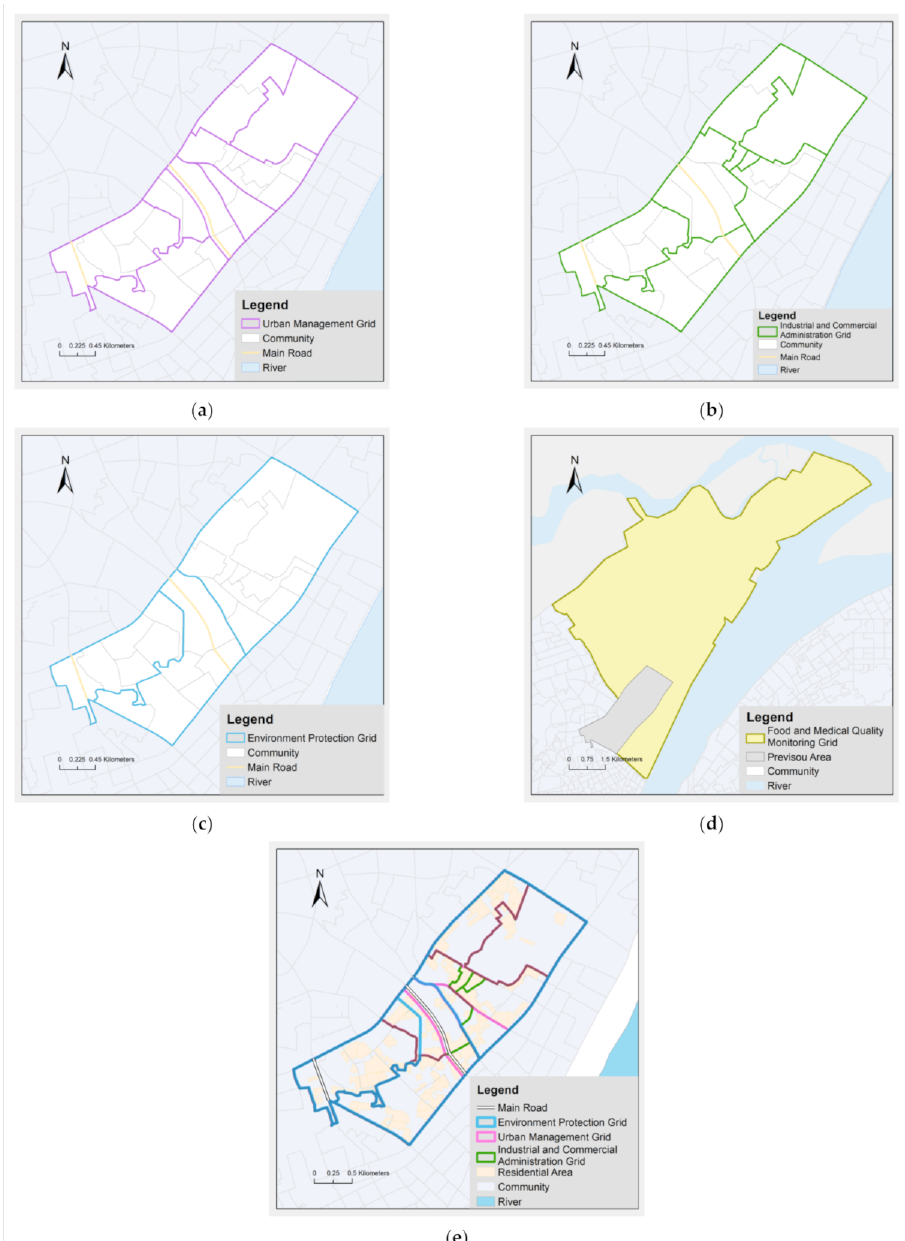
Figure 3. Domain-specific urban grids: ( a ) Urban management grid. The purple boundary represents the responsibility area of urban management law enforcement, relating to city image and sanitation; ( b ) Industrial and commercial administration grid. The dark green boundary represents the responsi- bility area of market supervision and administration, relating with market entities; ( c ) Environment protection grid. The blue boundary represents the responsibility area of environment supervision and environmental pollution control. ( d ) Food and medical quality monitoring grid. The dark yellow boundary represents the responsibility area of monitoring the food and medical quality; ( e ) Overlap of professional grids. Professional grids partition the space into spatial